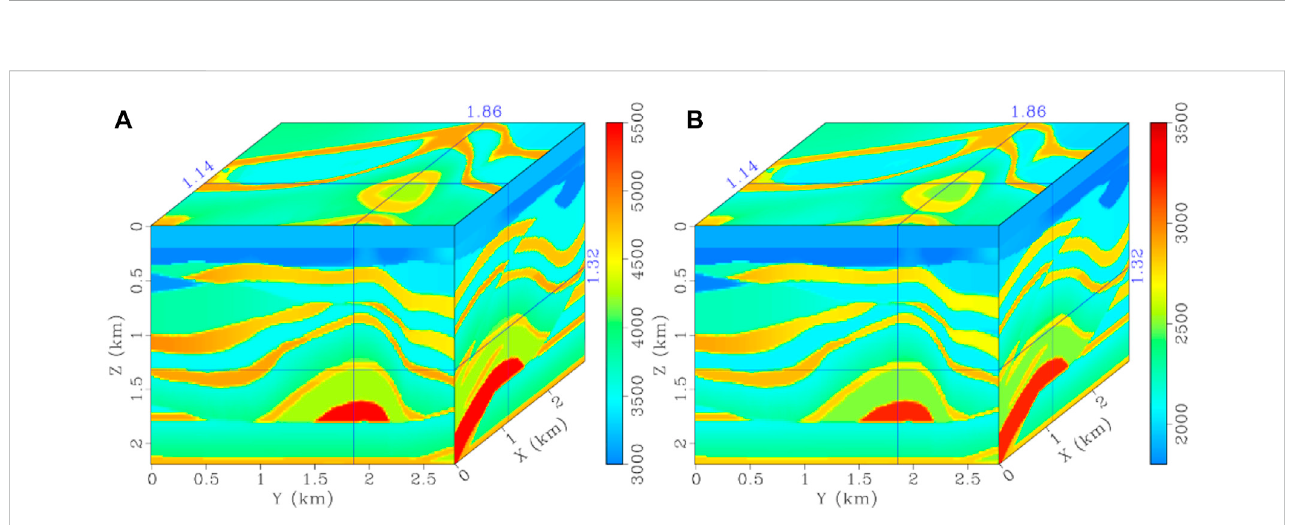
FIGURE 11 Modi fi ed overthrust models of (A) and (B) true P- and S-wave velocity models.